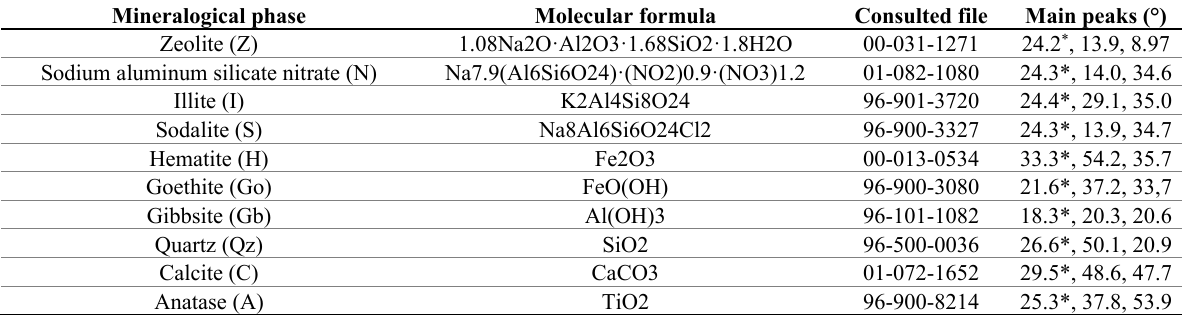
Table 4. Mineralogical phase, molecular formula, and consulted the file number of the phases found in the bauxite residues. Mineralogical phase